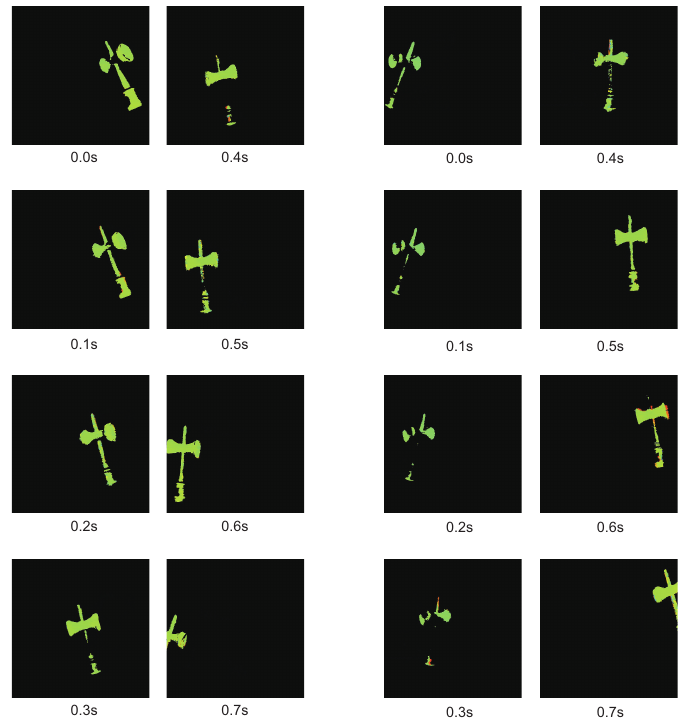
Figure 11. 3-D measurement without target